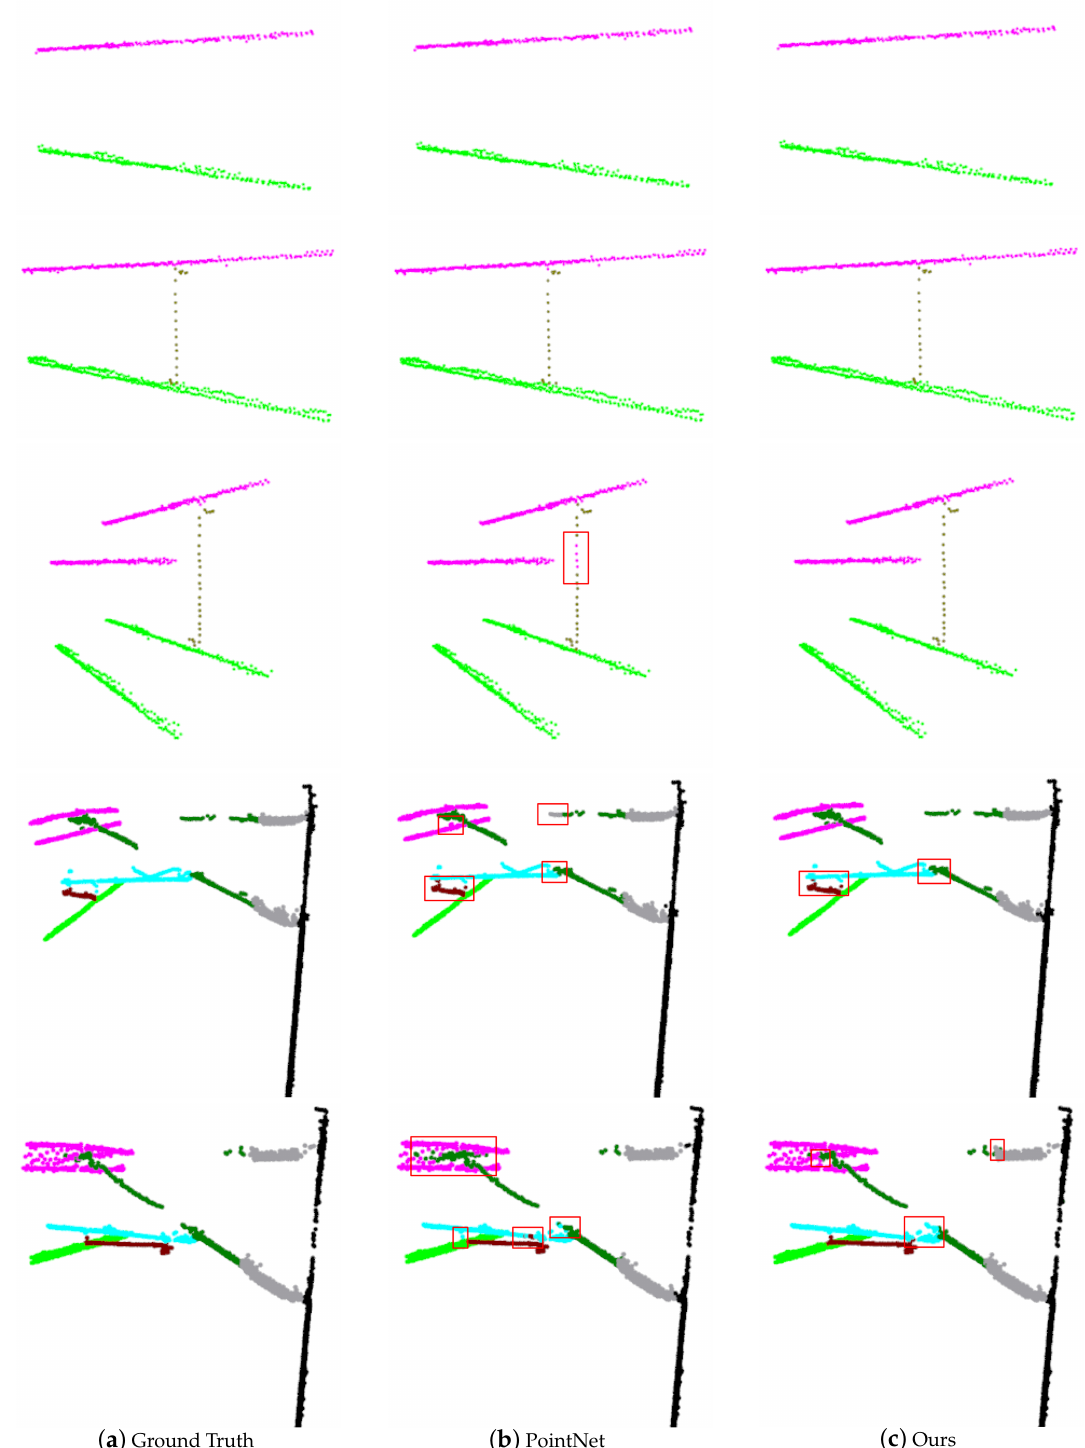
Figure 12. A comparison of the segmentation results. The first column is the ground truth. The second and third columns are the prediction of the PointNet and our model. The points belonging to different categories are colored differently (catenary wire in magenta, dropper in dark yellow, contact wire in green, insulator in gray, pole in black, cantilever in dark green, registration arm in cyan, and steady arm in dark red). The red areas are the main misclassified